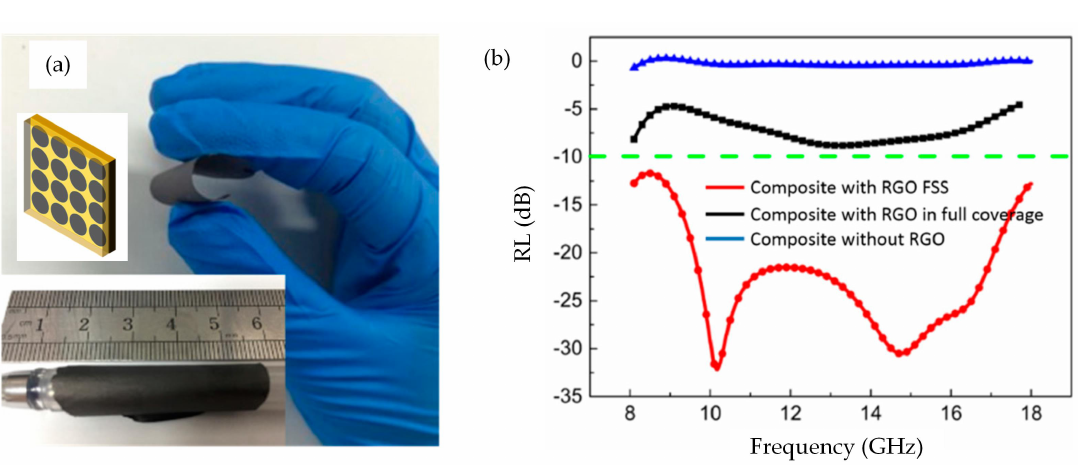
Figure 10. ( a ) image of the fabricated flexible multilayer (reduced graphene oxide) rGO. The upper inset illustrates the rGO based frequency selective surface (FSS) sandwiched between two dielectric layers and the lower inset demonstrates the dimensional of a unpatterned multilayer rGO; ( b ) the measured RL spectra without rGO (blue), with rGO in full coverage (black) and with rGO-FSS (red), reprinted with permission from Ref.